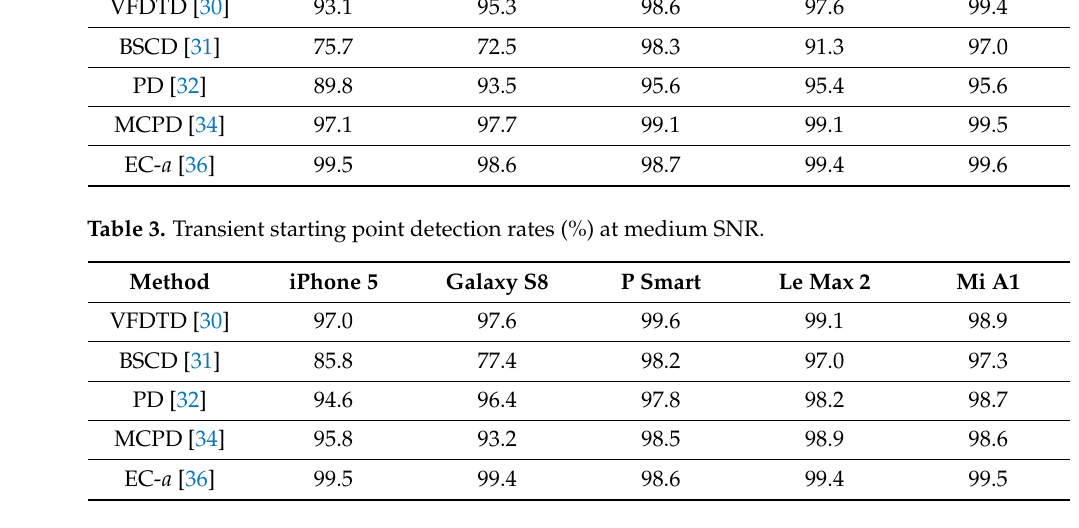
Table 4. Transient starting point detection rates (%) at high